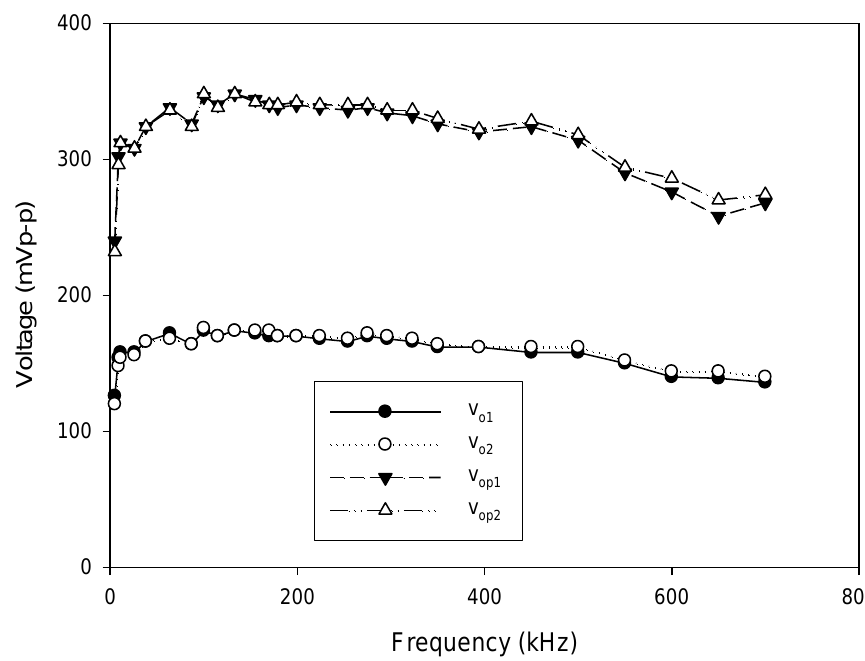
Figure 12. Measurement of the peak-to-peak voltage of quadrature sinusoidal waveforms.